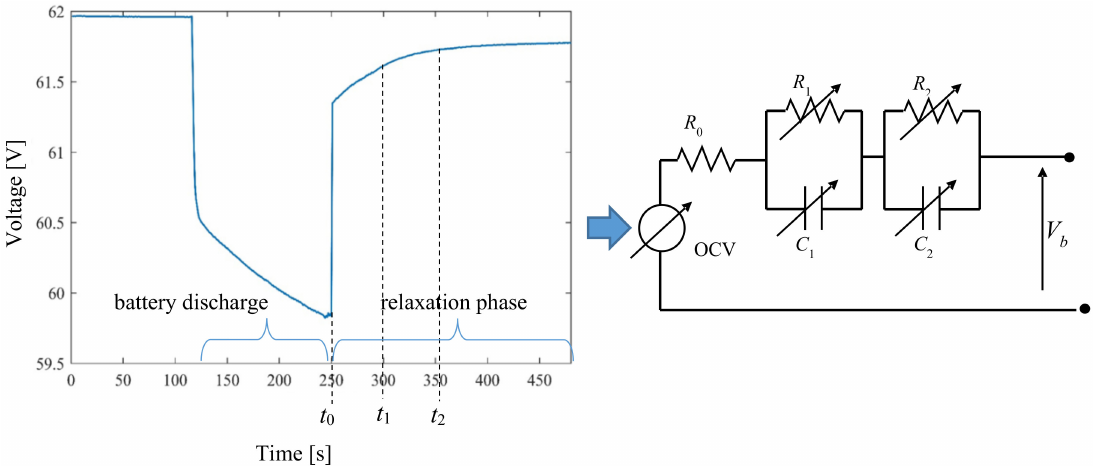
Figure 4. Battery voltage measurement (left) from which to derive the battery equivalent electrical model